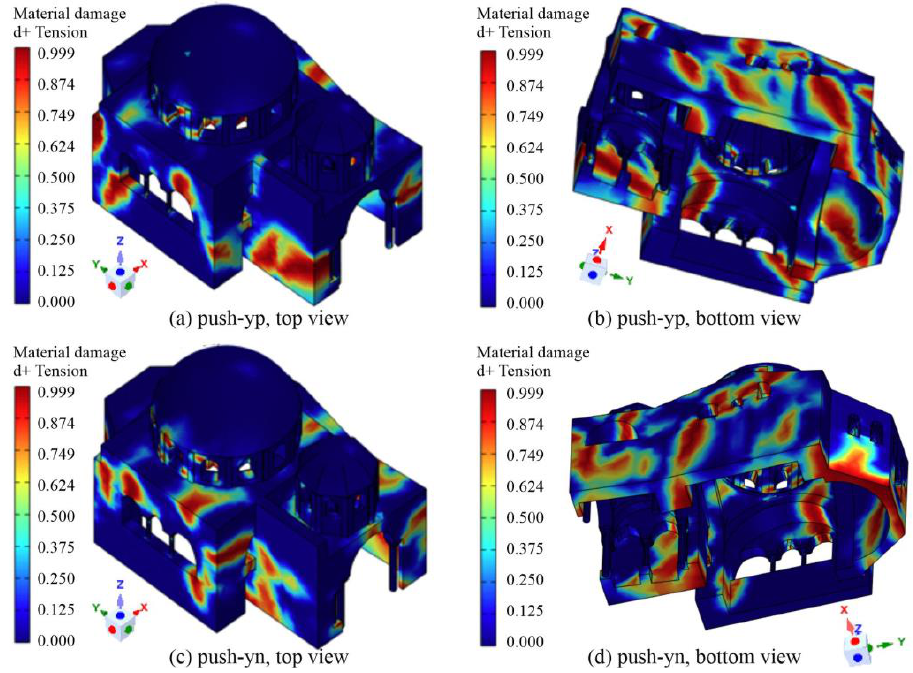
Figure 19. Material damages in the main structure under push-yp and push-yn loadings.